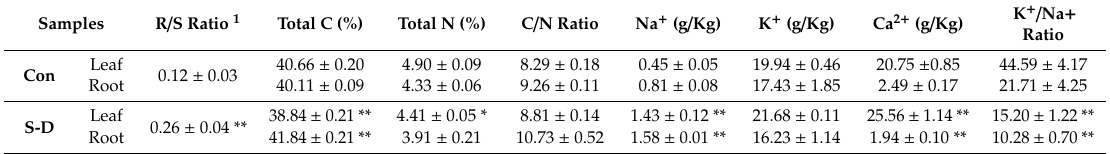
Table 1. Changes in R / S, C / N and ion content in stressed mulberry tissues.